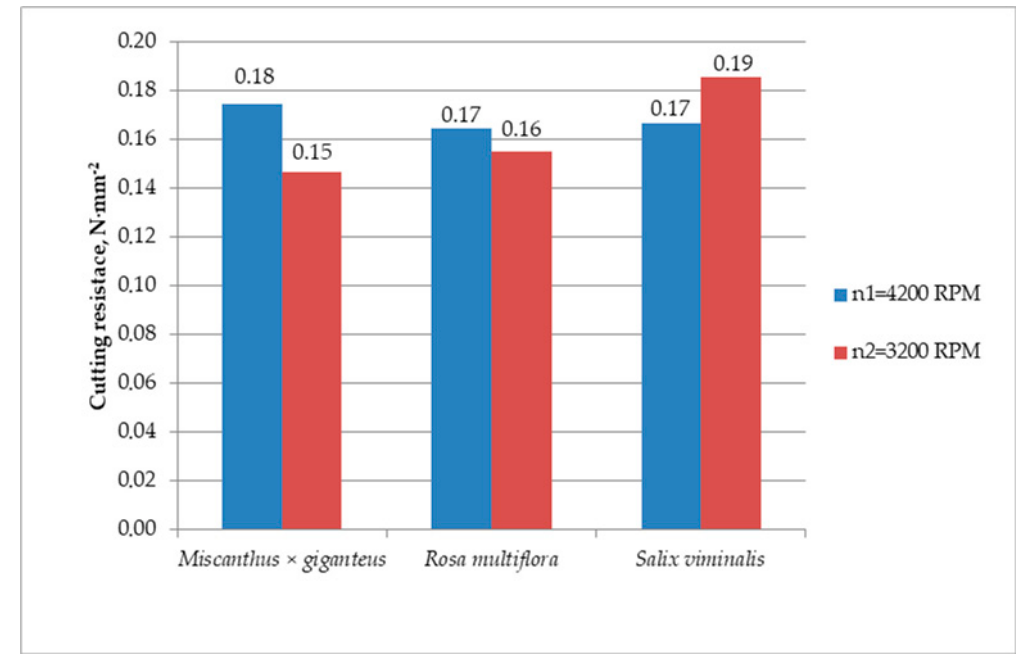
Figure 6. The average cutting resistance at variable rotation